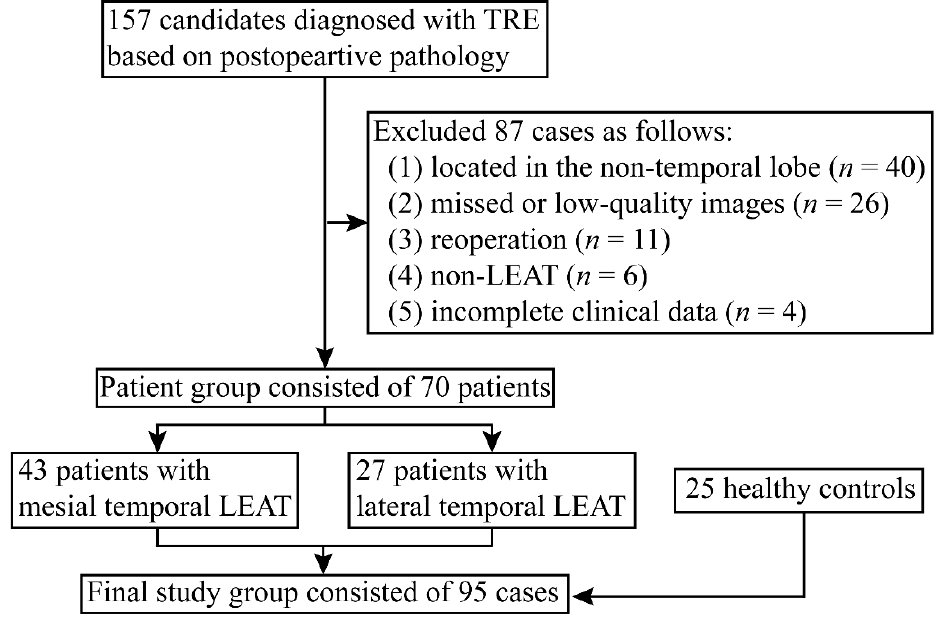
Figure 1. Flowchart of 157 consecutive patients diagnosed with tumor-related epilepsy. Eighty-seven patients were excluded due to exclusion criteria. Finally, this study consisted of 70 patients and 25 healthy controls. TRE: tumor-related epilepsy; LEAT: long-term epilepsy-associated tumor.